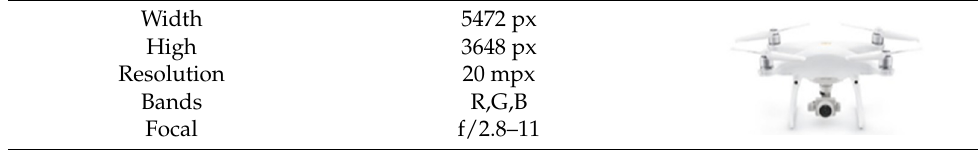
Table 1. Characteristics of the drone used (Phantom 4 Pro) [24].